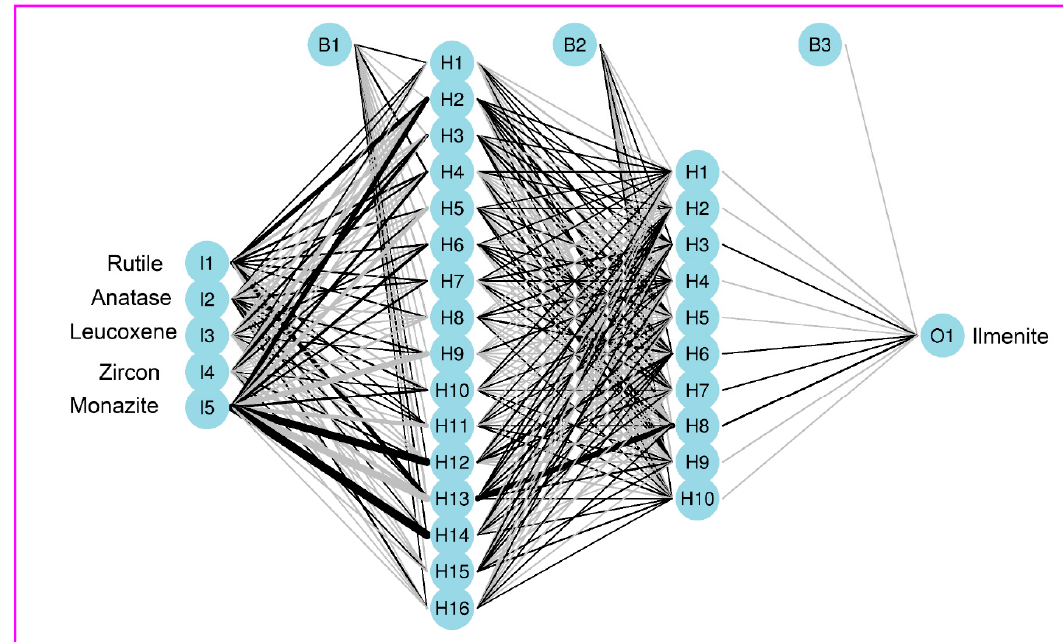
Figure 12. Artificial neural network (ANN) model for estimating the content of ilmenite.